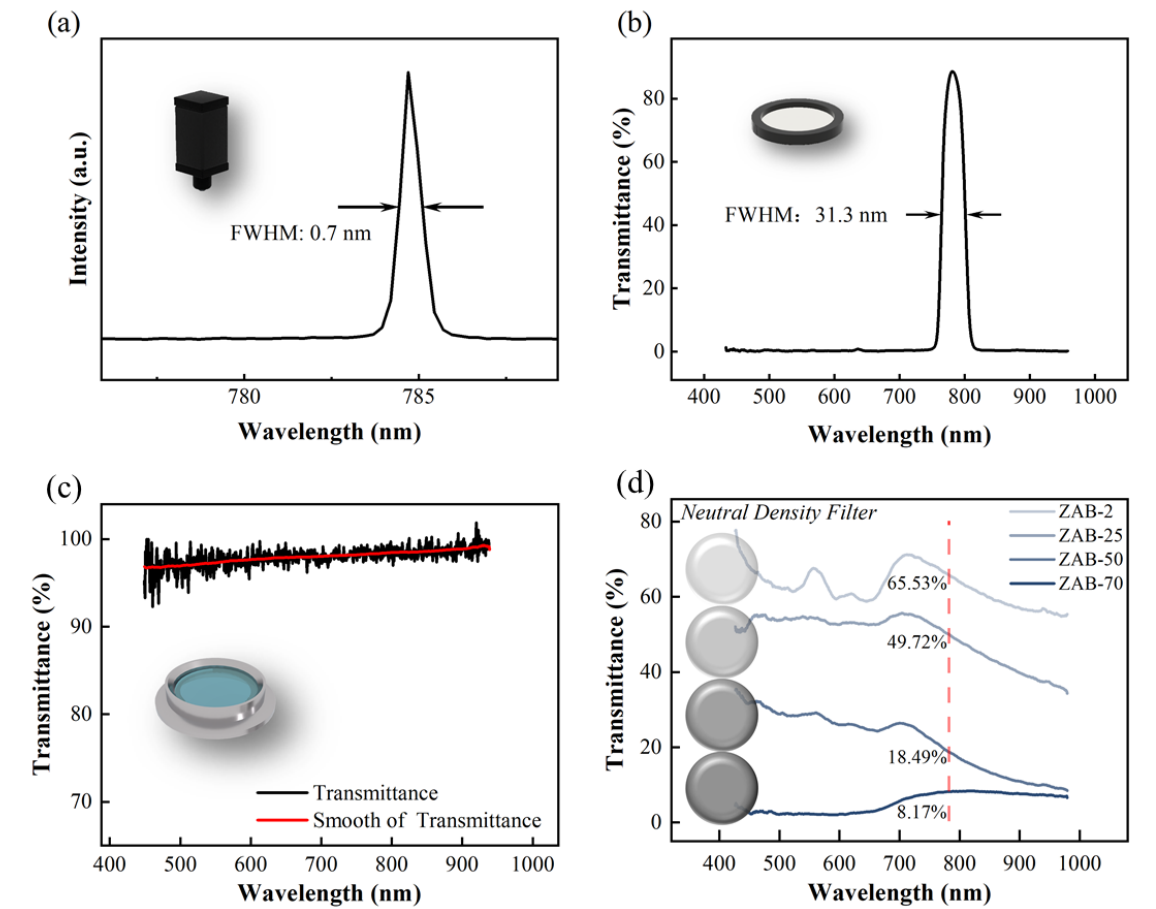
Figure 8. Spectrum test of optical components: ( a ) laser spectrum; ( b ) transmittance spectrum of bandpass filter; ( c ) transmittance spectrum of quartz flange; ( d ) transmittance spectrum of neutral density filter.